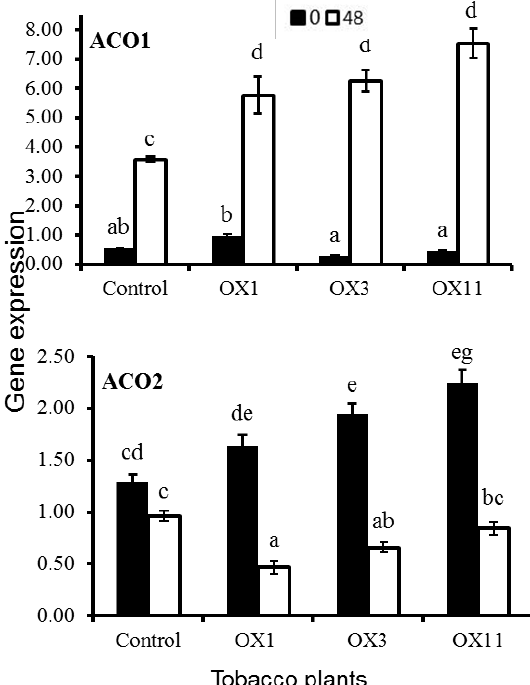
Figure 6. Quantitative Realtime PCR analysis of transcript levels of 1-aminocyclopropane-1-carboxylic acid oxidase 1 ( ACO1 ) and ACO2 in Nicotiana tabacum flowers (stage 5) of control (C) and transgenic PI3K (OX1, 3 and 11) tobacco lines. Detached flowers were stored for 48 h for analysis. Data represents mean ± SE from three biological replicates. ANOVA was performed on data and significant ( p < 0.05) differences between means were determined using Duncan test. Statistical significance among means is denoted by different letters (a–g).